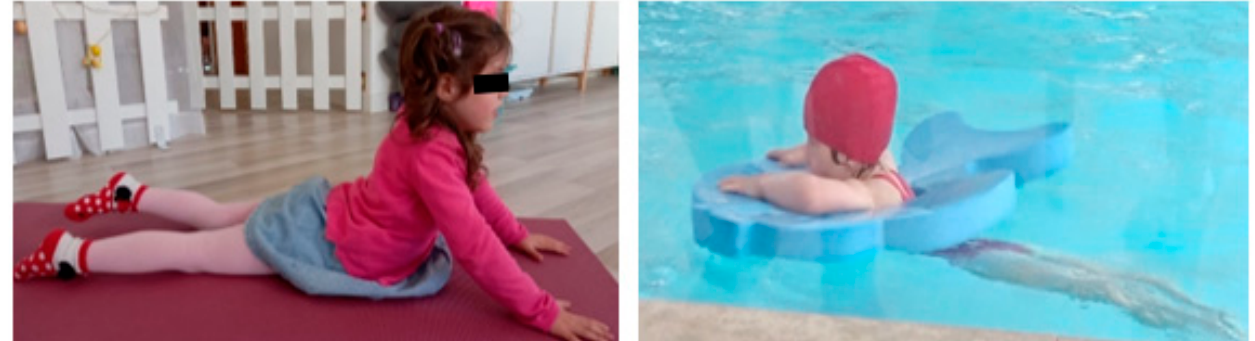
Figure 12. Leisure and sports activities (yoga and swimming).